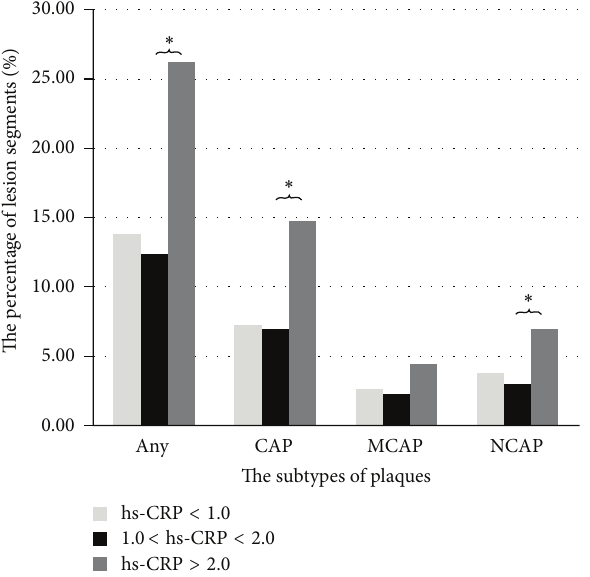
Figure 2: Percentage of patients with various plaque subtypes according to CRP category. Subjects with high hs-CRP levels were more likely to have any plaque, CAP, or NCAP compared with the second and third tertiles. ∗ refers to a statistically significant association between hs-CRP and the subtype of